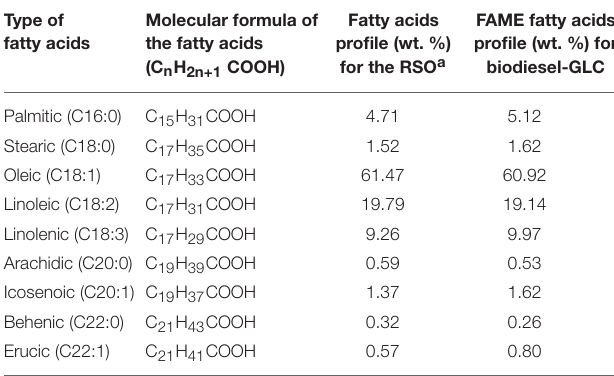
TABLE 1 | Fatty acid profile of the RSO feedstock and the FAME obtained from reactively coupled biodiesel and GLC productions. Type of Molecular formula of fatty acids the fatty